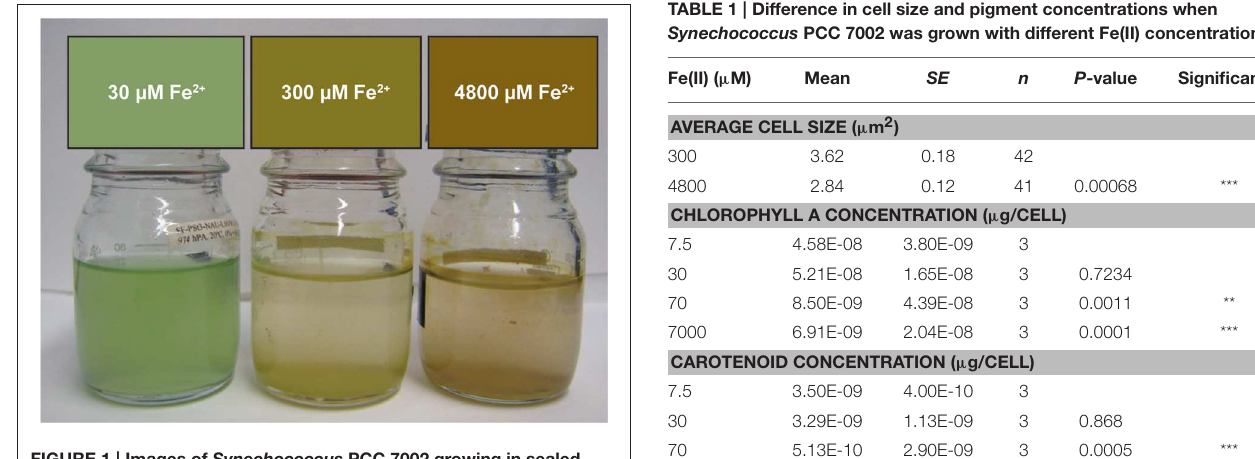
FIGURE 1 | Images of Synechococcus PCC 7002 growing in sealed bottles that began anoxic with different concentrations of Fe(II). These images were taken 5 days after inoculation.